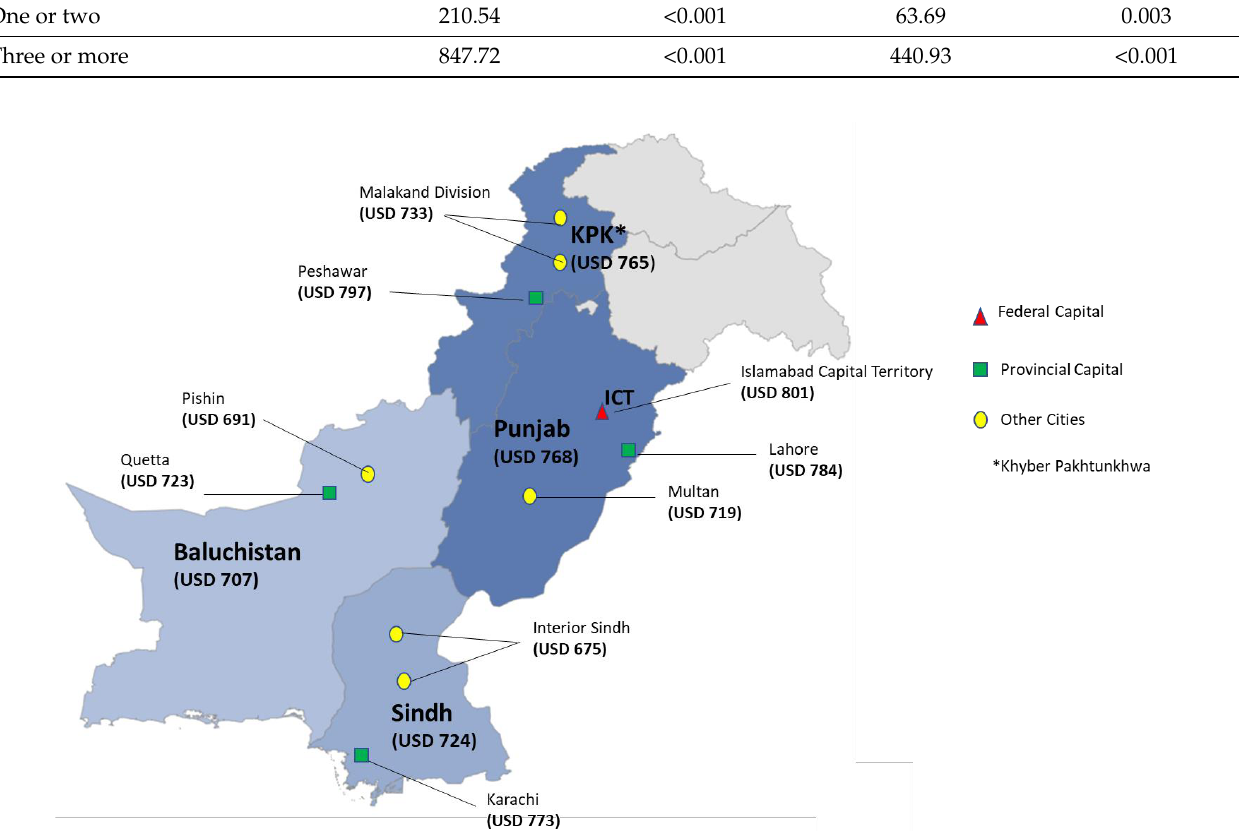
Figure 2. The cost comparison of the region computed per person diabetes management cost in USD.